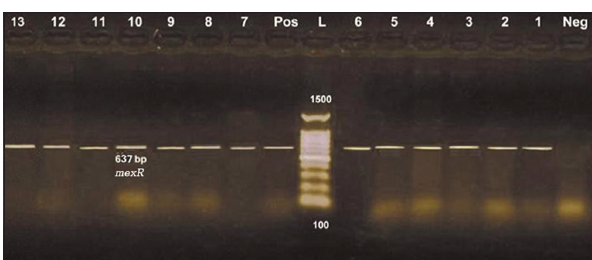
Figure-1: Uniplex polymerase chain reaction detection of antibiotic-resistant mexR operon in Pseudomonas aeruginosa isolates showing: L: 100 bp DNA ladder. Lanes 1-13: P. aeruginosa isolates. Lane Pos.: Positive control; amplification of 637 bp represented mexR . Lane Neg.: Negative control.